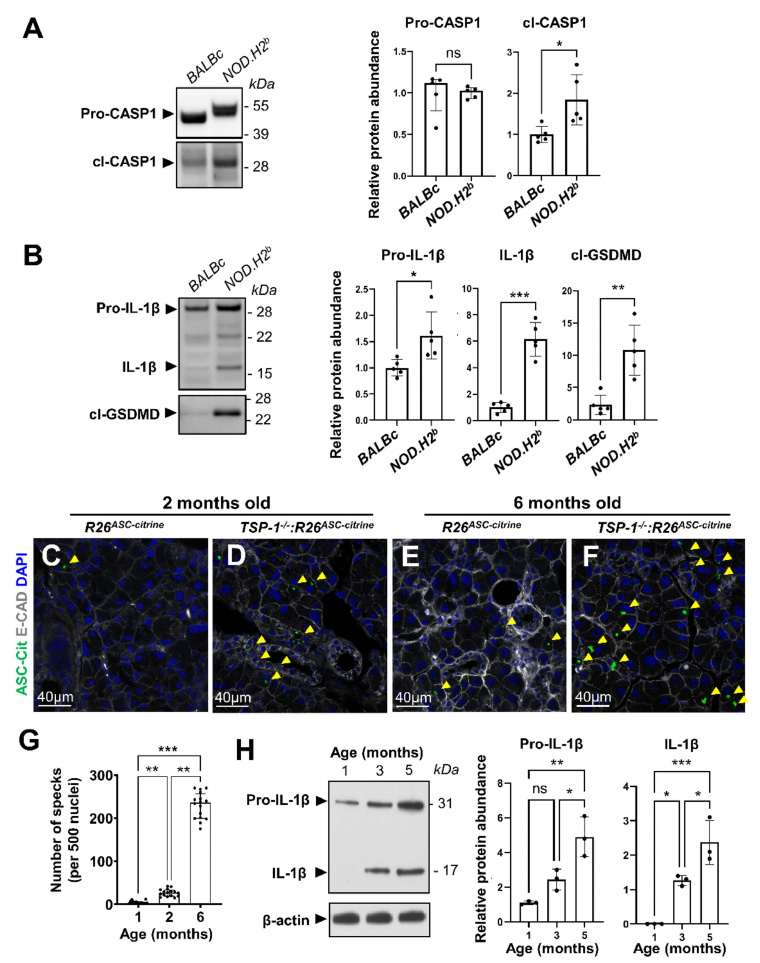
Figure 2. Analysis of inflammasome activation in the LG of Sjögren’s syndrome mouse models . ( A , B ) Representative results and quantification for Western blot analysis of ( A ) Pro-CASP-1